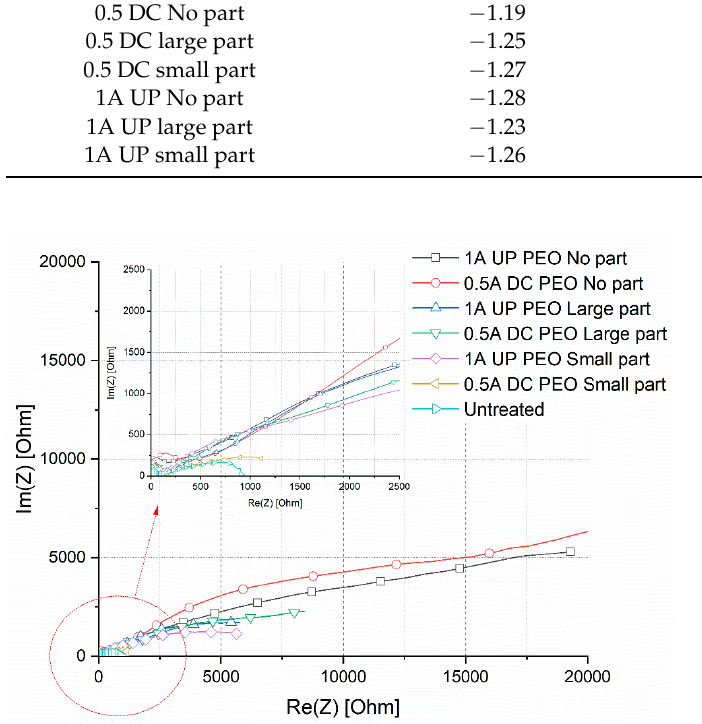
Figure 9. Results of the EIS tests in term of Nyquist plot. In the high left, the zone at the high frequencies can be observed in more detail. Test electrolyte: 0.1 M Na 2 SO 4 and 0.05 M NaCl.